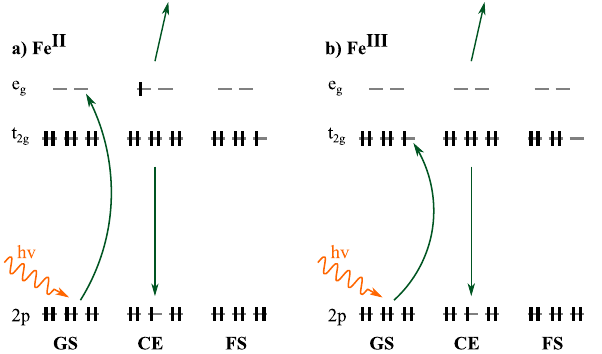
Figure 3. Scheme of the participant decay process following the lowest iron-centred Fe 2 p resonant excitation for (a) Fe II and (b) and Fe III octahedral complexes. The initial/ground state (GS), the core-excited (CE) intermediate state, and the oxidised final state (FS) after participant decay are shown, where green arrows indicate the excitation and decay